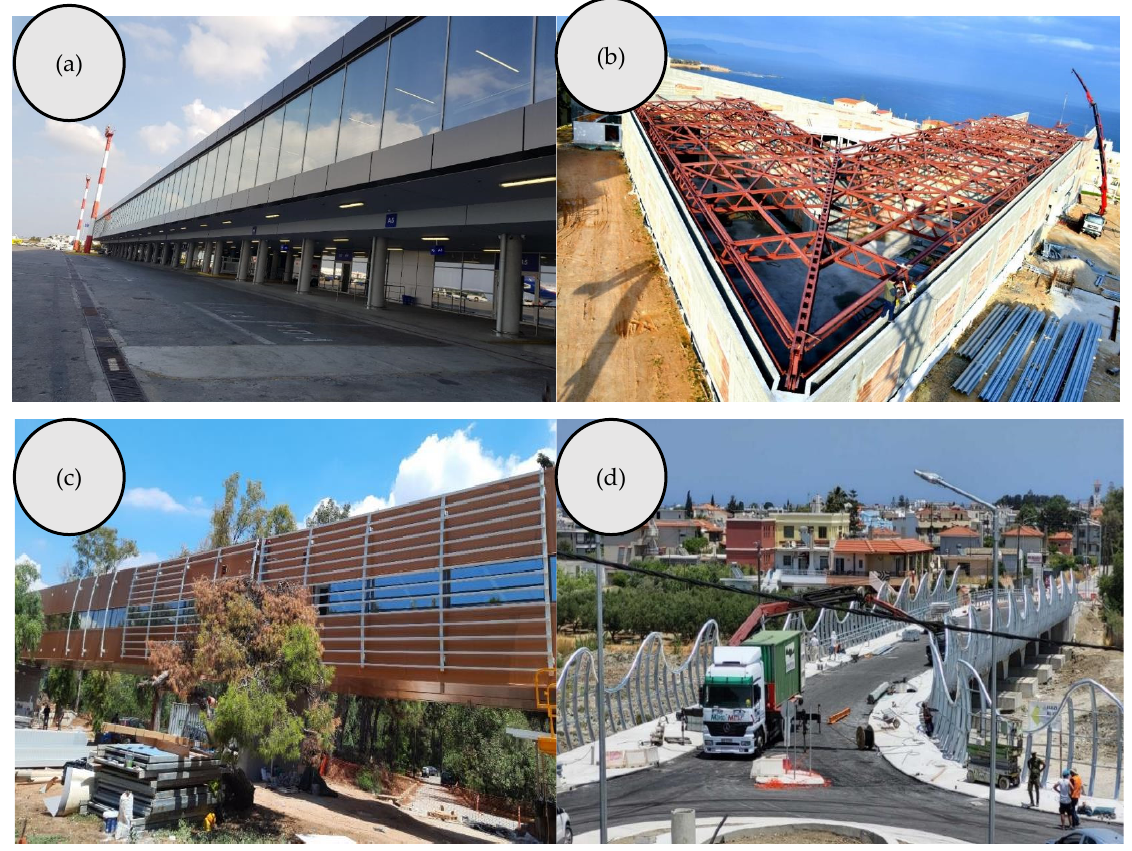
Figure 1. ( a ) Airport, ( b ) roof canopy, ( c ) pedestrian bridge, ( d ) bridge railing.